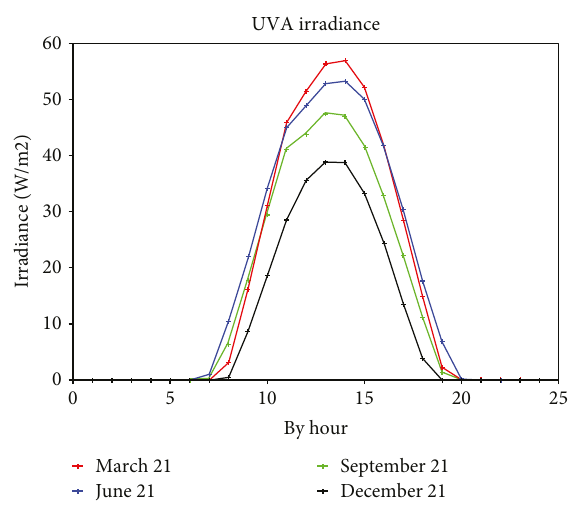
Figure 2: Typical UVA irradiance in the city of Aguascalientes, Mexico, as a function of hour, for the solstices and